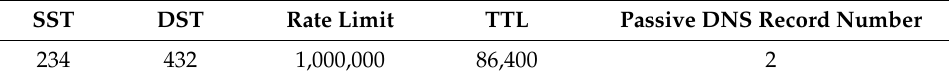
Table 6. Exemplary output of the Passive DNS with CETP support–Session